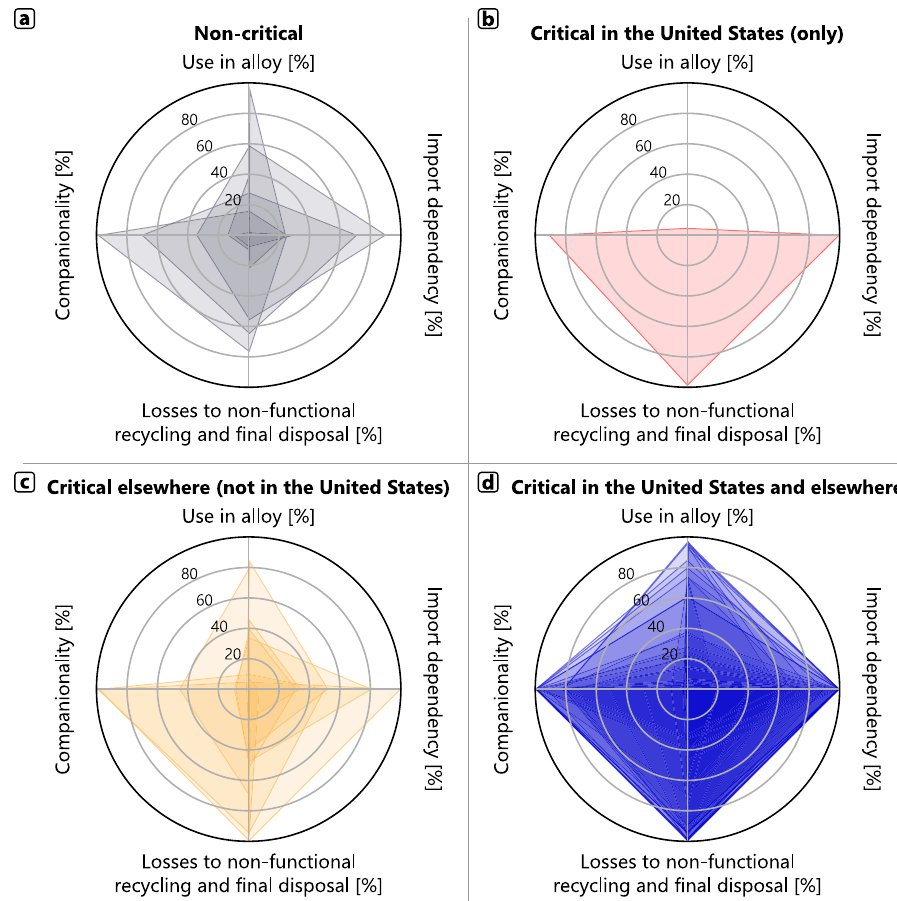
Fig. 4 Radar charts for four criticality risk variables for 69 elements: use in alloy forms, U.S. import dependency, losses to nonfunctional recycling and fi nal disposal, and companionality. a Elements not designated as critical by any country (six elements), ( b ) elements designated as critical by the United States only (one element), ( c ) elements designated as critical by other countries but not the United States (nine elements), and ( d ) elements designated as critical by the United States and one or more other countries (53